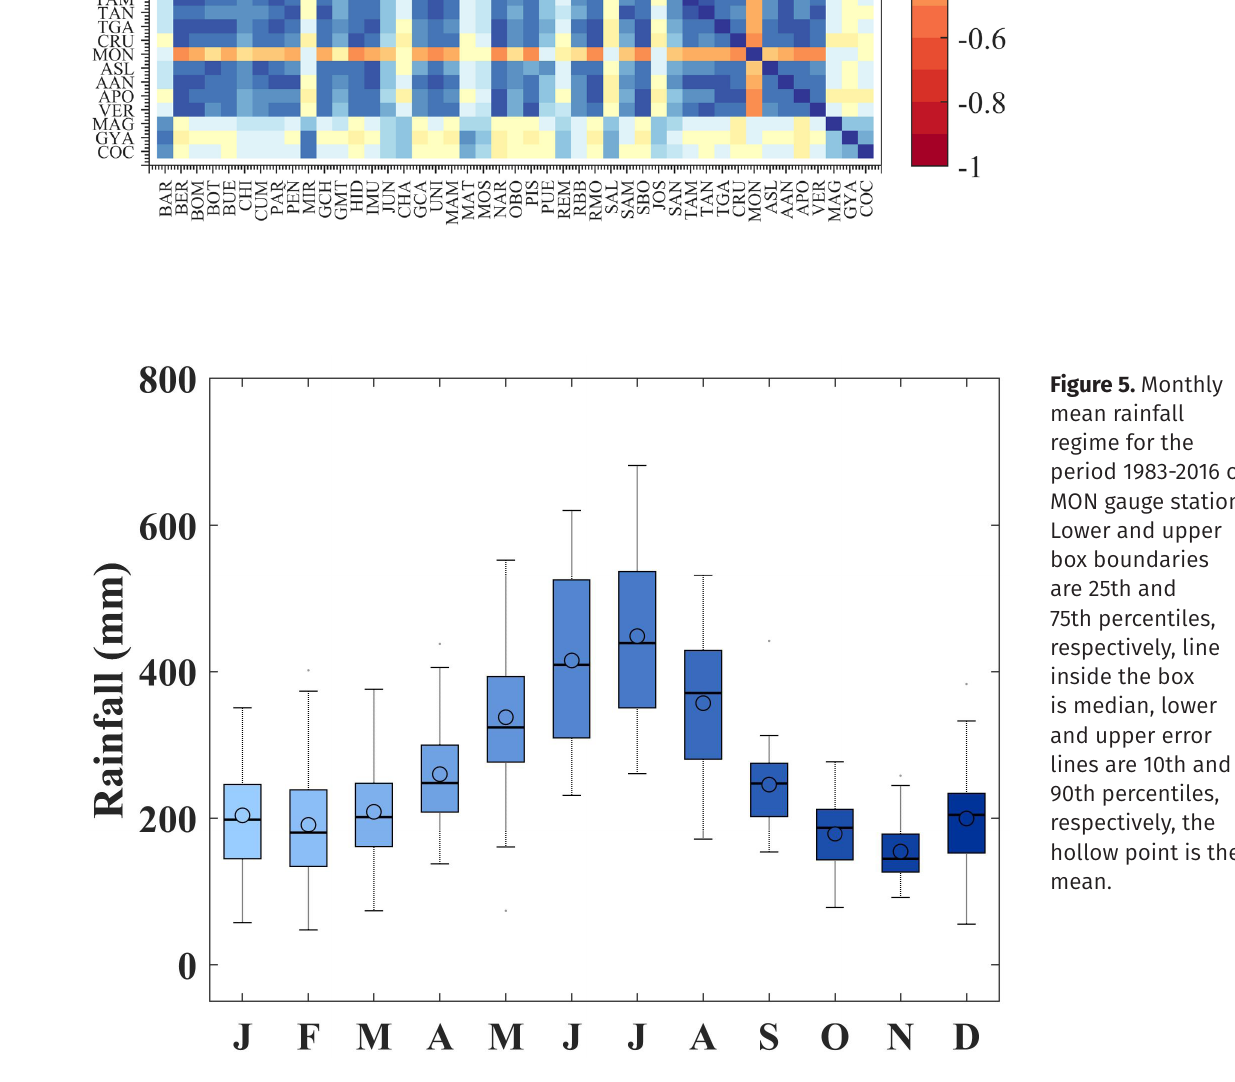
Figure 4. Pearson’s correlation coefficients between gauge